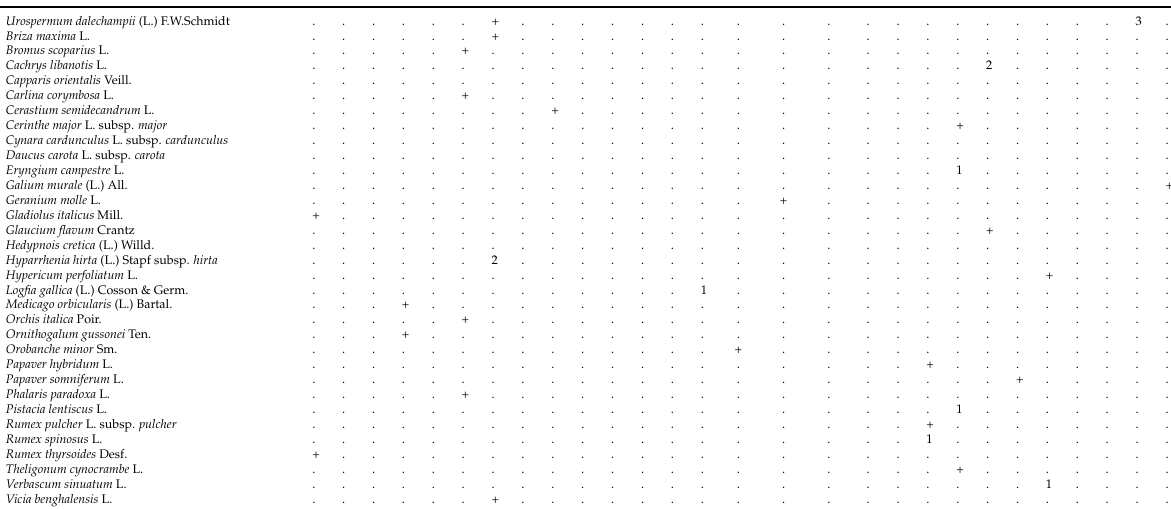
Table A4. Phytosociological relev é s from the Island of Capo Passero (SE Sicily)—psammophilous vegetation. Cluster